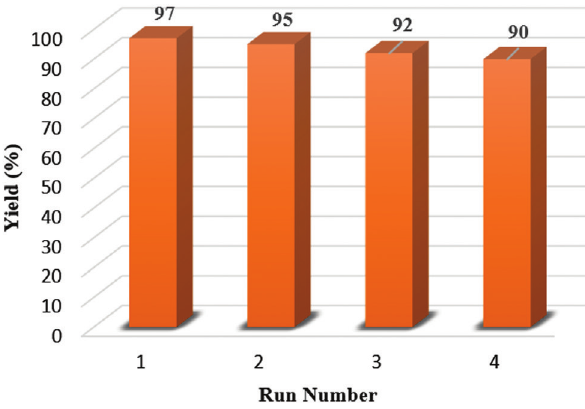
Figure 1: Reusability of TPAB for the synthesis of 5d